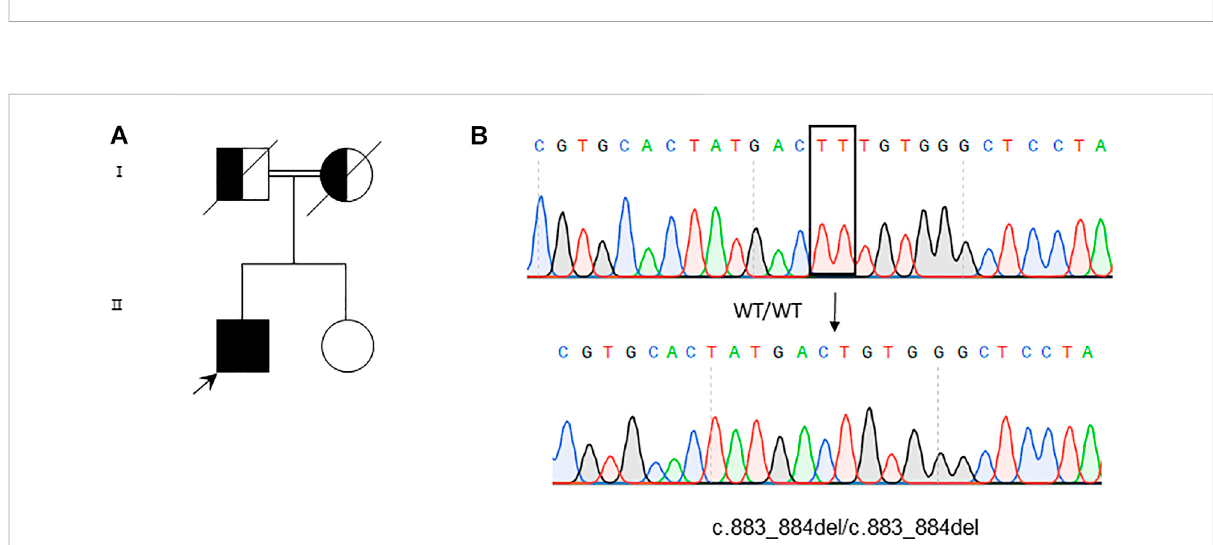
FIGURE 5 Whole-exome sequencing and variants veri fi cation by Sanger sequencing. (A) Genogram of the patient. (B) Sequence analysis reveals homozygous TT deletion at 883 and 884 of the CHST14 gene in the patient. The deleted nucleotides are boxed in the WT sequence (upper panel), while the arrow indicates the position of the deleted nucleotides in the mutation sequence (lower